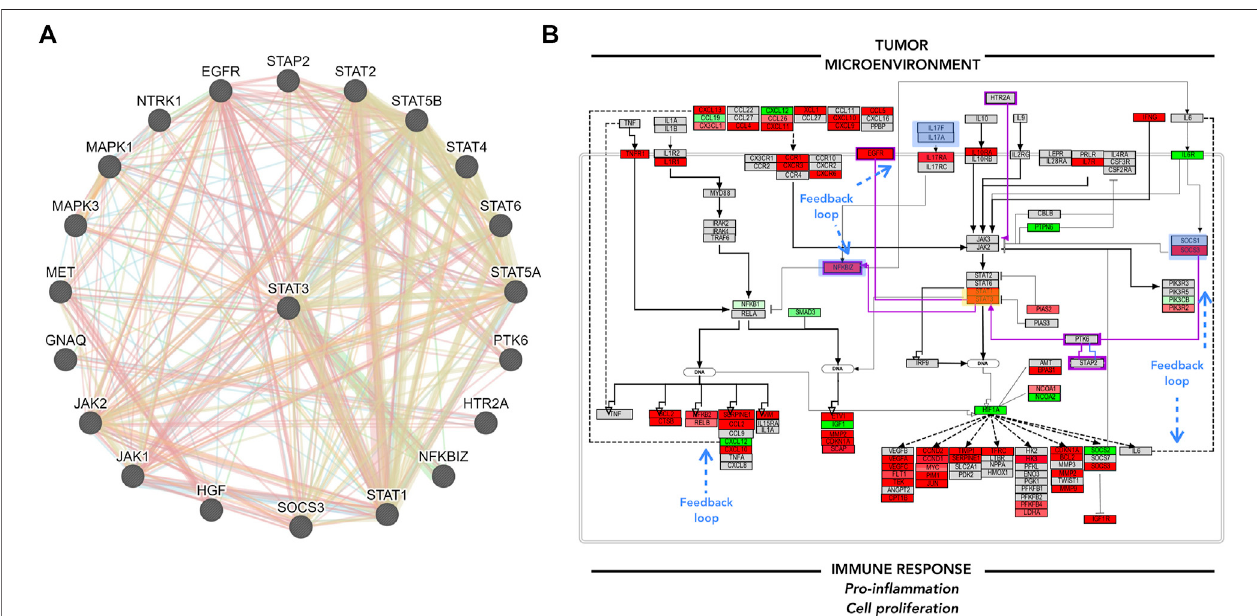
FIGURE 5 | GeneMANIA focus and Pathvisio de novo pathway contextualization. (A) GeneMANIA results for STAT3; interactor molecules can either represent physical interaction (red), co-expression (purple), genetic interaction (green), shared protein domain (yellow). (B) Pathvisio NFKB and JAK/STAT signaling pathway section with added elements from GeneMANIA highlighted in purple; STAT3 analyzed gene highlighted in yellow box, blue boxes represent feedback loops. analyzed gene highlighted in yellow box, blue boxes represent feedback